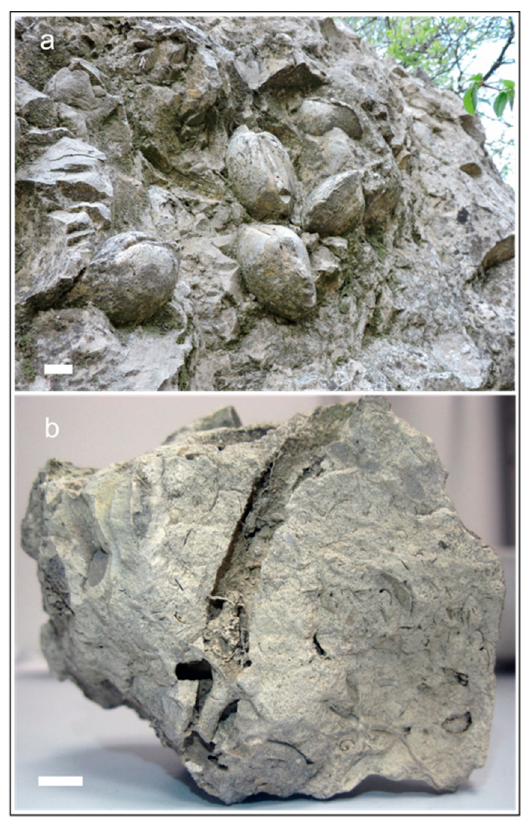
Figure 4. Representative seep-carbonate facies. ( a ) Densely packed articulated bivalves from the Sasso delle Streghe carbonate pinnacle (Montebaranzone area, outcrop 1 in Figure 1). ( b ) Large conduit and a complex network of vuggy fabric and doughnut structures from Poggio Campane outcrop (8 in Figure 1). Bar length = 2 cm.